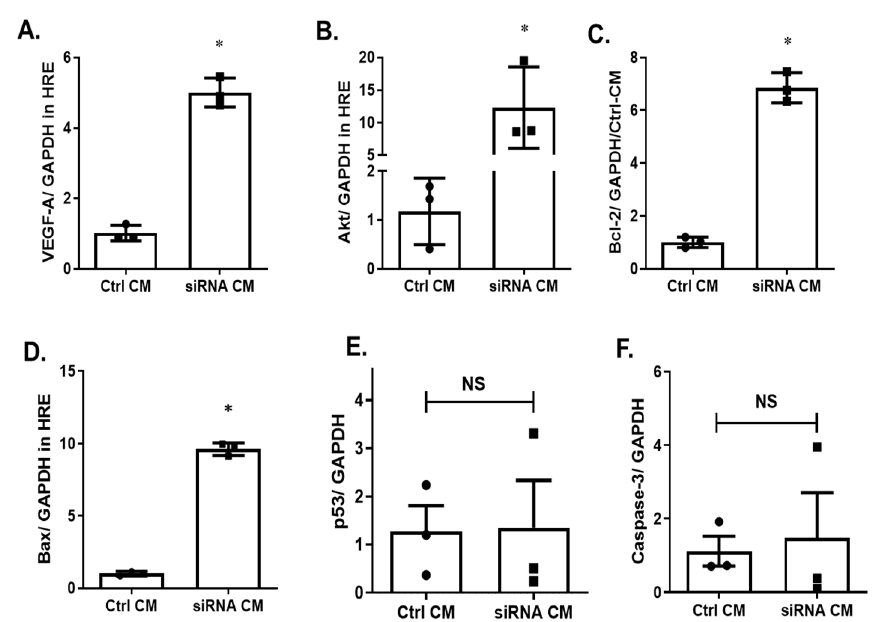
Figure 5. Silencing p75 NTR expression on MSCs improves paracrine effect in HREs. RT-PCR analysis showed that treatment of HREs with CM of p75 NTR -silenced MSCs significantly increased gene expression of angiogenic and survival factor transcripts, including VEGF-A ( A ), Akt ( B ), Bcl-2 ( C ) and some of the apoptotic markers including BAX ( D ) , but no change was observed in p53 ( E ) or caspase-3 ( F ) transcripts when compared to HREs treated with CM of control cells. *, significant at p < 0.05; NS, not significant. Significance was detected by unpaired student T-test, n = 3.